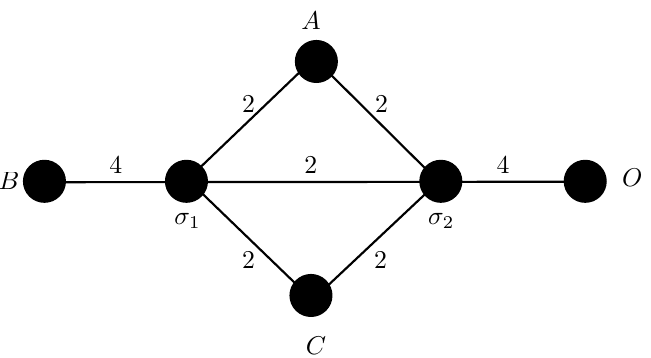
Figure 10 . The graph g consists of three boundary vertices A, B, C and purifier O along with two internal vertices σ and σ . Edge capacities are labeled for each edge and give the maximum 1 2 number of threads which can be placed on it. Viewing the graph as a multi boundary wormhole geometry, the edge capacities also gives the area of the minimal area surface or throat between the connecting